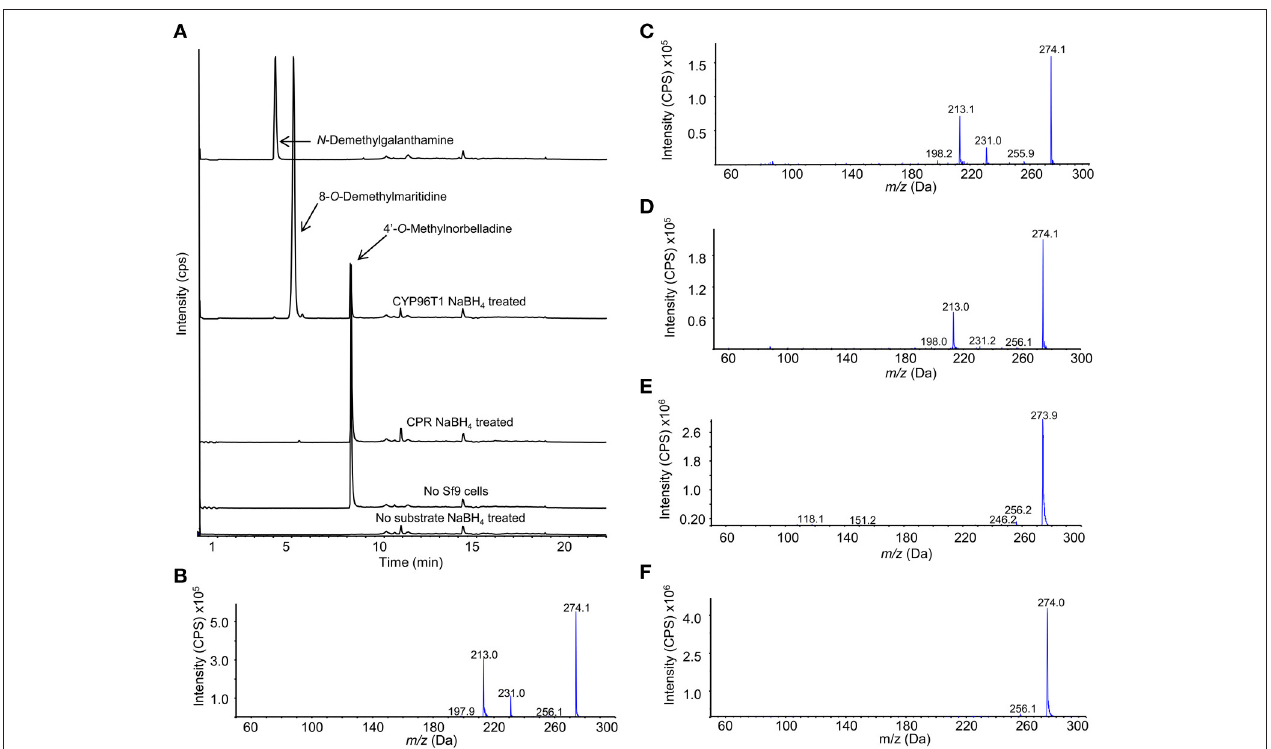
FIGURE 8 | LC-MS/MS Enhanced Product Ion (EPI) scan of sodium borohydride (NaBH 4 ) treated CYP96T1 assays with 4 ′ - O- methylnorbelladine substrate. (A) Chromatograph with the following sample runs top to bottom: N -demethylgalanthamine standard, CYP96T1 assay, CPR assay, assay with no Sf9 cells and CYP96T1 assay without 4 ’ - O -methylnorbelladine. (B) EPI fragmentation pattern of the N -demethylgalanthamine standard peak eluting at 4min. (C) EPI fragmentation pattern of the N -demethylgalanthamine product in the CYP96T1 assay. (D) EPI fragmentation pattern of epi-N -demethylgalanthamine from the CYP96T1 assay. (E) EPI fragmentation pattern of (10b S ,4a R )- and (10b R ,4a S )-noroxomaritidine standard reduced to stereoisomeric 8- O- demethylmaritidine. (F) EPI fragmentation pattern of reduced (10b S ,4a R )- and (10b R ,4a S )-noroxomaritidine product from CYP96T1